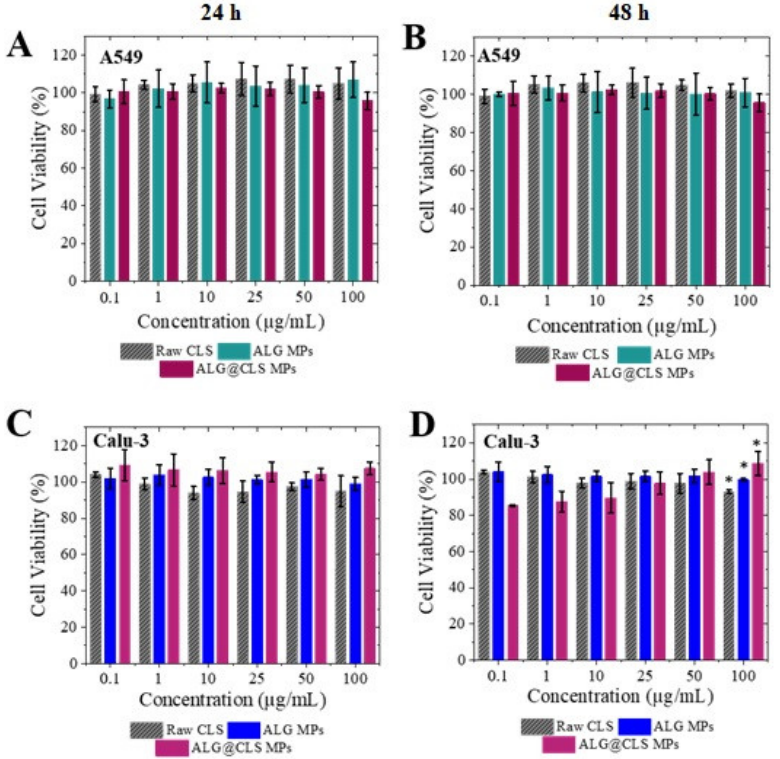
Figure 9. Cytotoxicity of free drug and alginate microparticles. Graphs indicate cell viability at two different times. A549 ( A ) 24 h and ( B ) 48 h. Calu-3 ( C ) 24 h and ( D ) 48 h. Notes: * Significant differences ( p < 0.05) between samples studied compare to raw colistin sulfate (mean ± SD, n = 3).